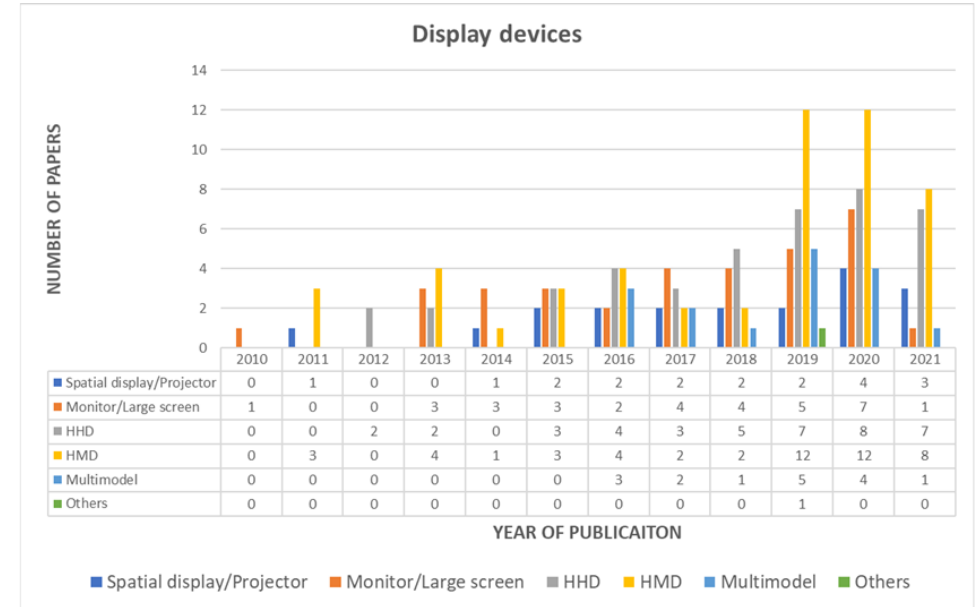
Figure 13. Number of articles about AR display devices in manufacturing over years 2010 –